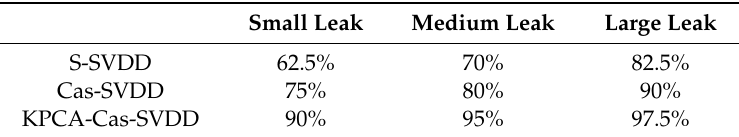
Table 5. A comparison of the results of detection accuracy.